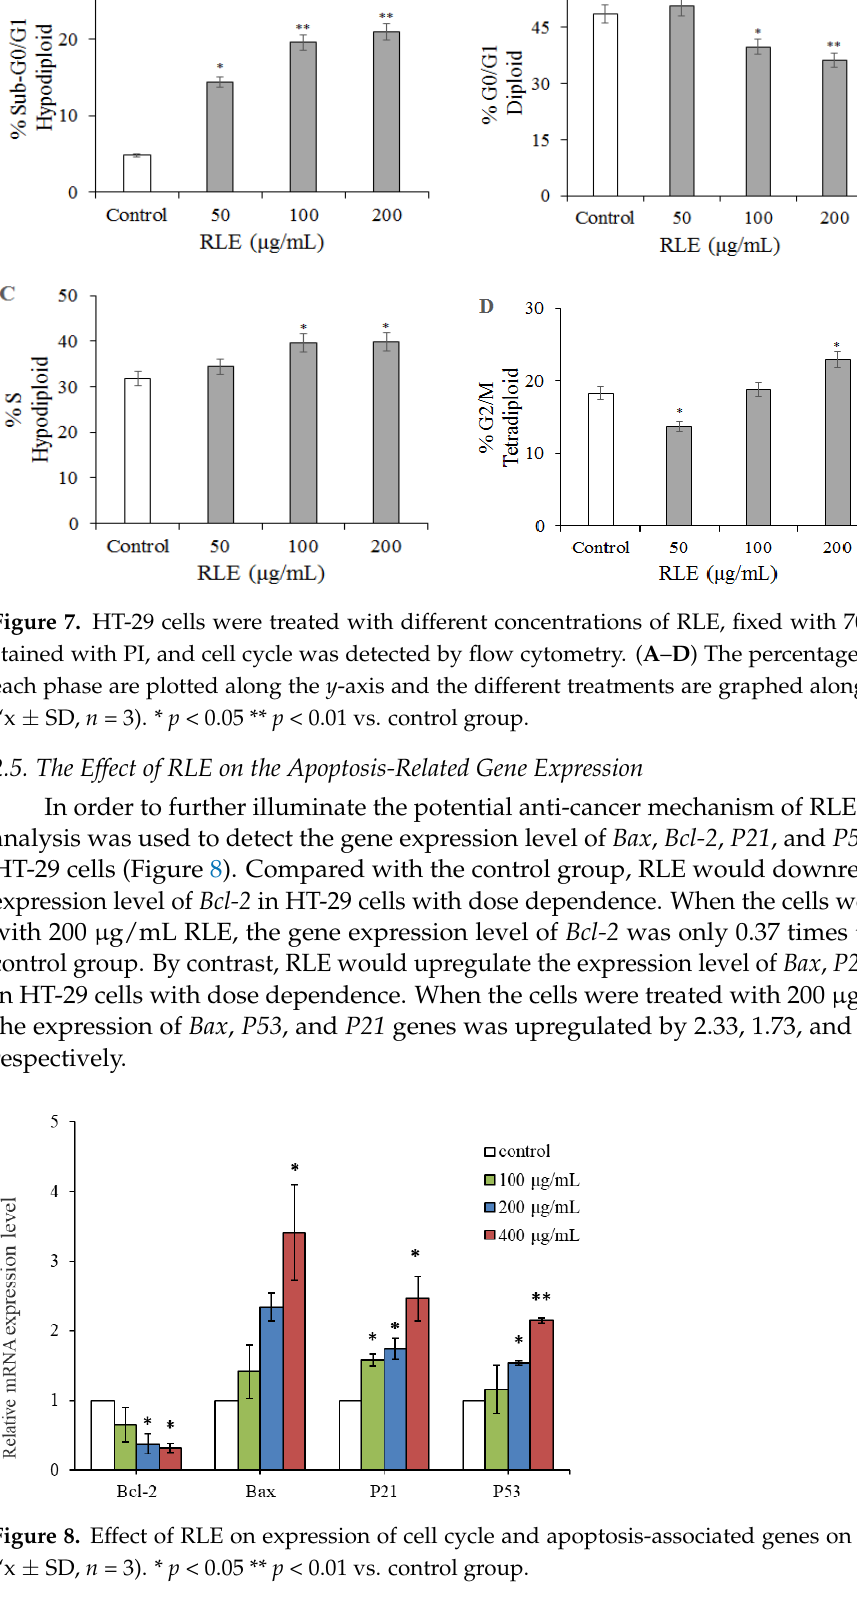
Figure 6. The effect of RLE on the cell cycle distribution of HT-29 cells by flow cytometry.